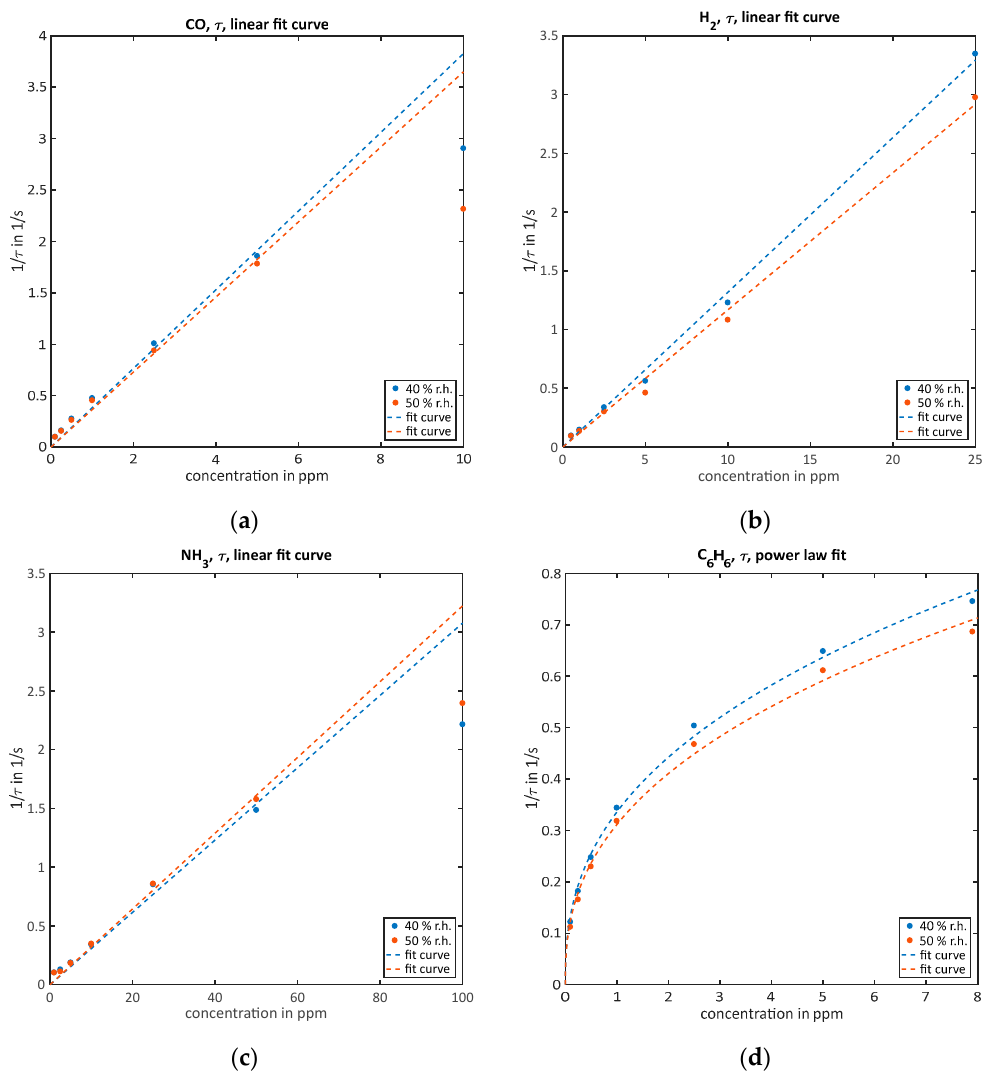
Figure 4. Quantification of the correspondent gases via the τ -evaluation and their fit curves for both humidities: ( a ) CO, linear fit curve; ( b ) H 2 , linear fit curve; ( c ) NH 3 , linear fit curve; ( d ) C 6 H 6 , power law fit. Table 3. Fitting parameters for all gases using the τ